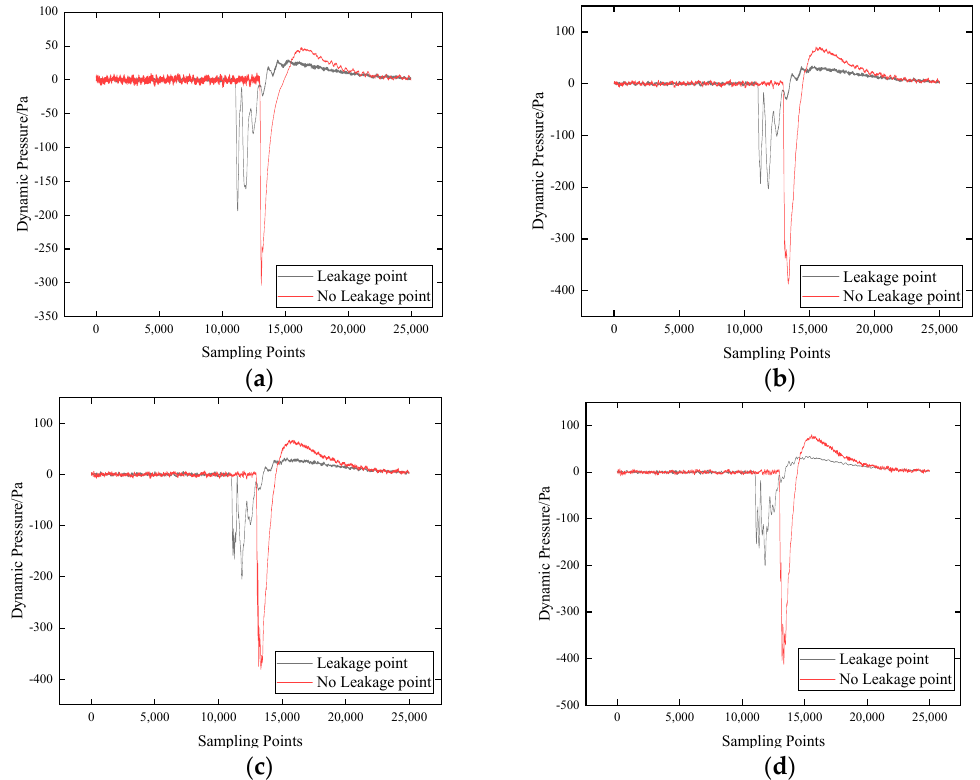
Figure 11. Characteristics of pressure response signals with or without a leakage hole to be detected: ( a ) sensor 1; ( b ) sensor 2; ( c ) sensor 3; ( d ) sensor 4. ( a ) sensor 1; ( b ) sensor 2; ( c ) sensor 3; ( d ) sensor 4.